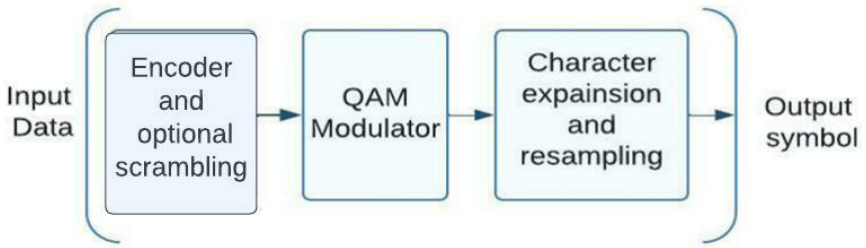
Figure 5. Aspect of the WSMA scheme concerned with structural transmission.